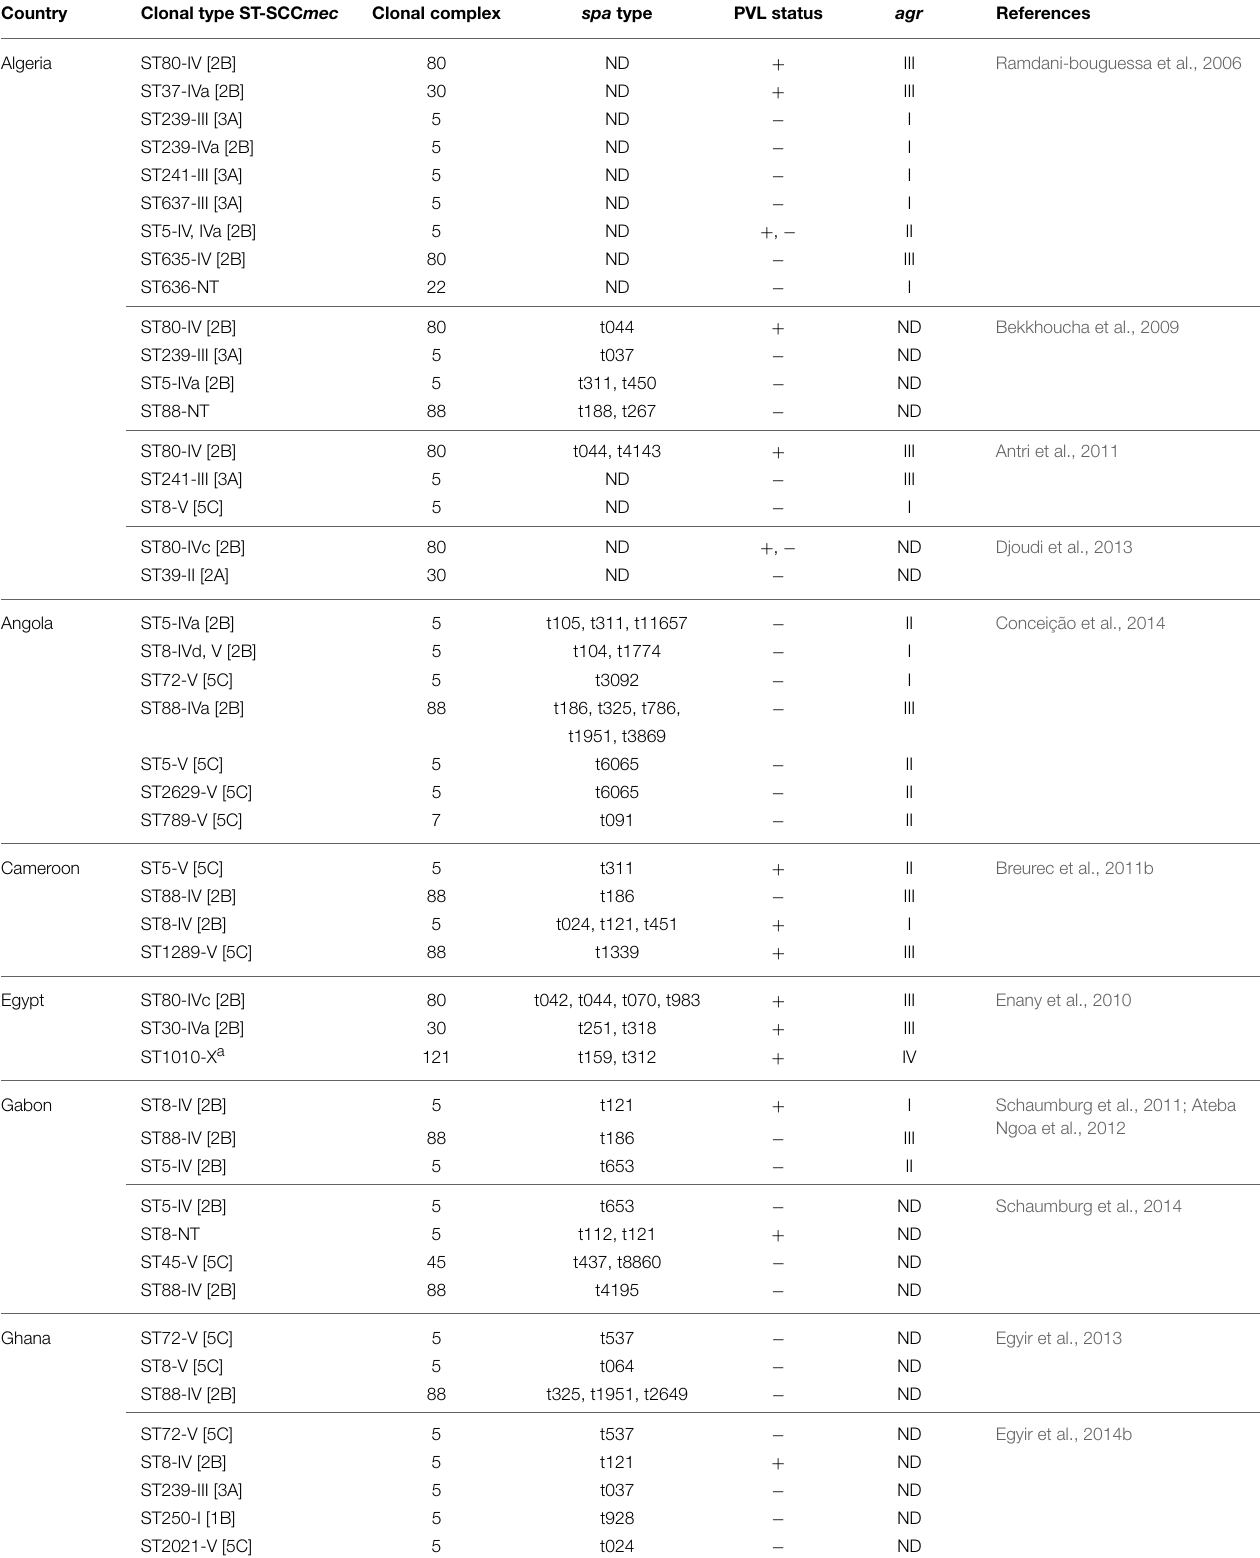
TABLE 2 | Methicillin resistant Staphylococcus aureus clones reported in 34 eligible